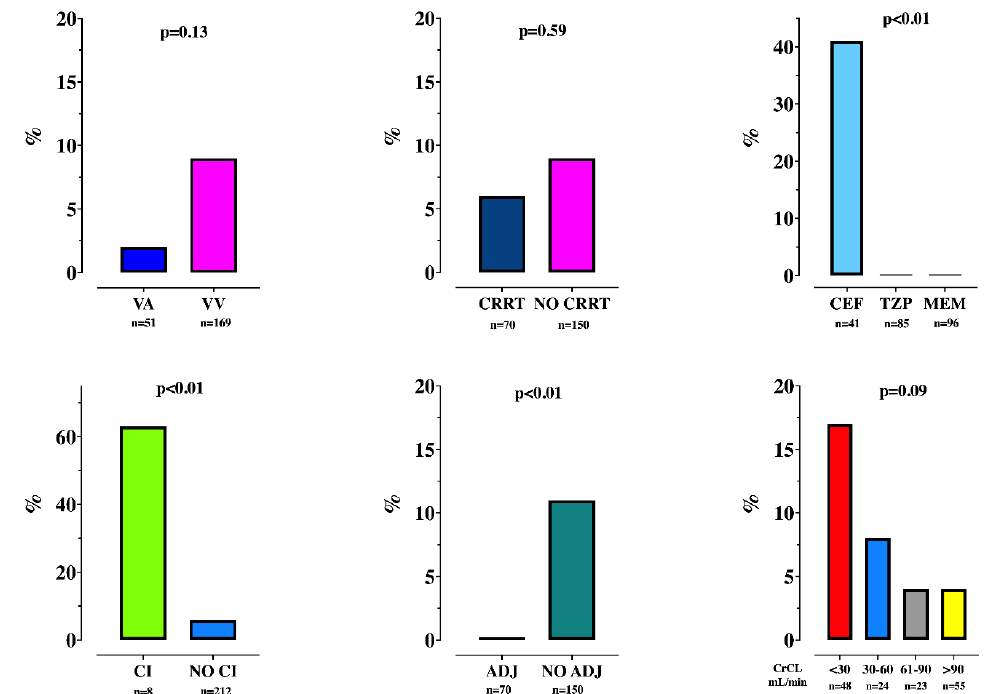
Figure 2. Proportion of therapeutic drug monitoring (TDM) with toxic drug levels, according to various patient characteristics. VA = veno-arterial; VV = veno-venous; CRRT = continuous renal replacement therapy; CEF = ceftazidime/cefepime; TZP = piperacillin; MEM = meropenem; CI = continuous infusion; ADJ = drug regimen adapted to renal function; CrCL = clearance of creatinine.